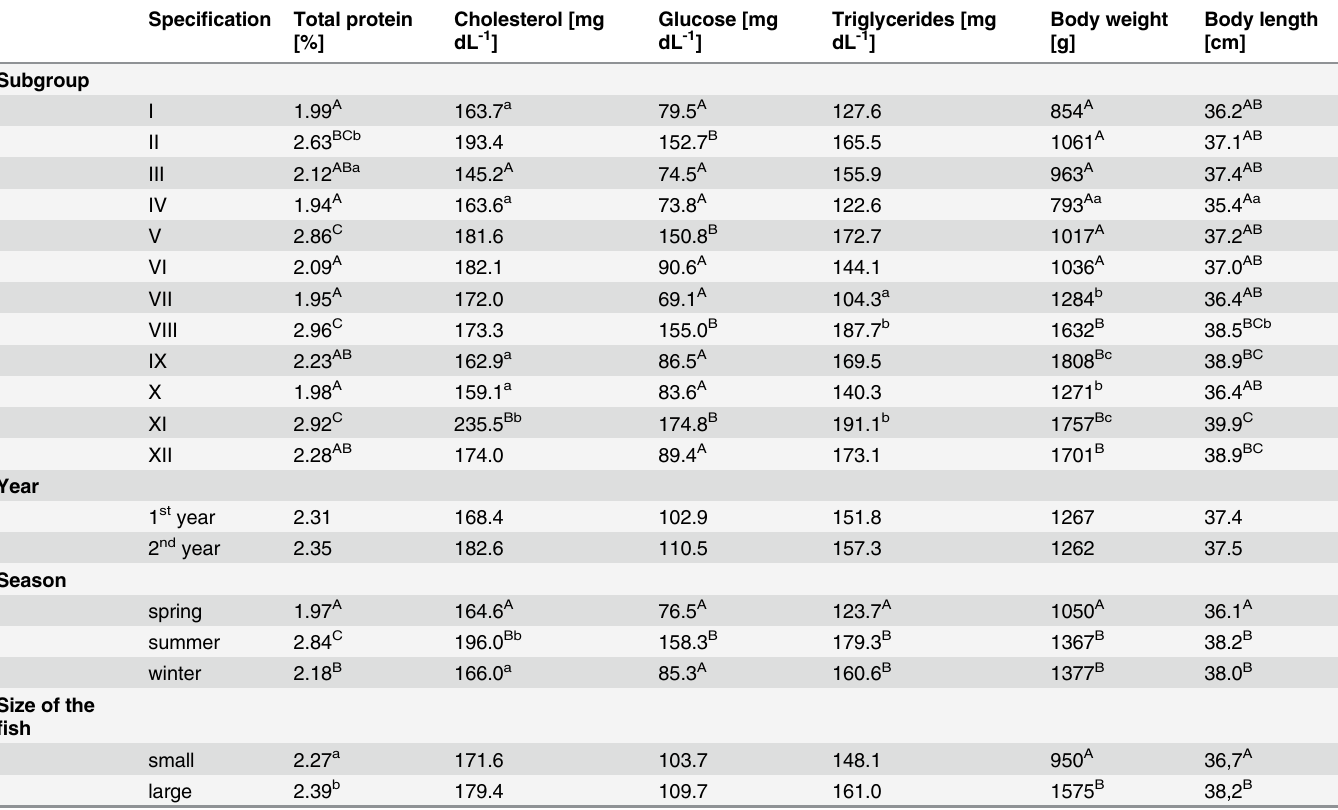
Table 5. Levels of total protein, cholesterol, glucose, triglycerides as well as fish size in experimental subgroups and groups. Speci fi cation Total protein